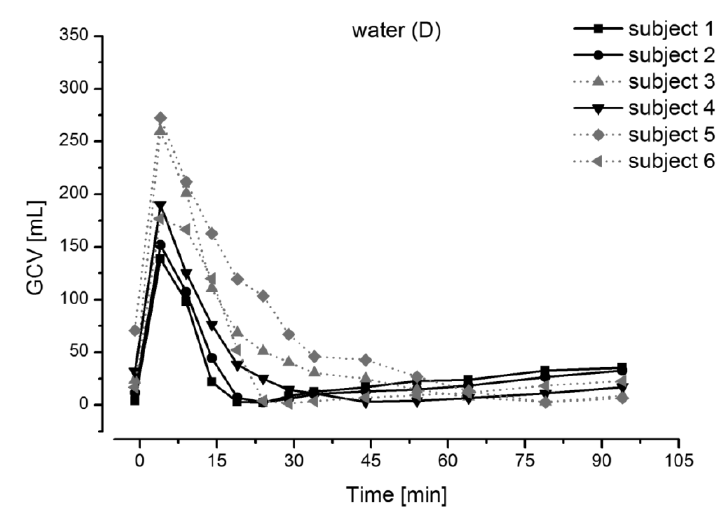
Figure 1. Gastric volume changes after administration of 240 mL of water in fasted state. Reprinted from Reference [27] with permission from the American Chemical Society.